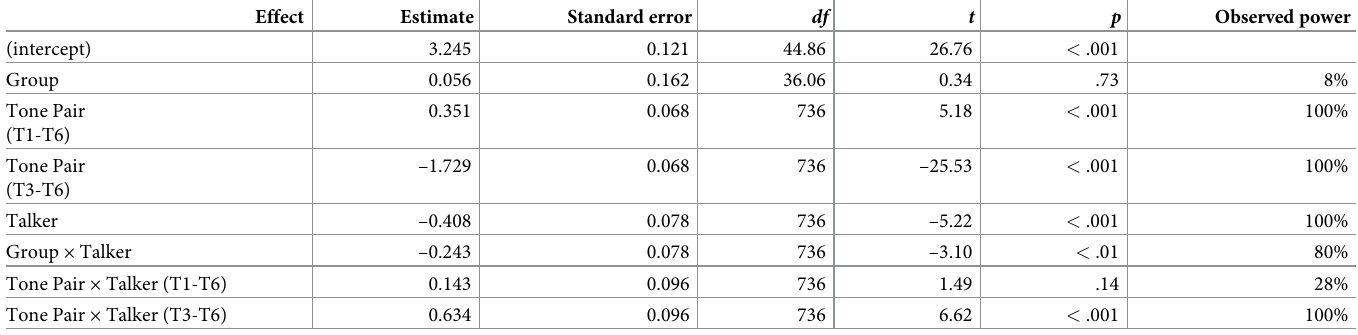
Table 4. Best linear mixed-effects model on d- prime scores of the participants from the morning and evening groups in the pretest and three posttests of AX